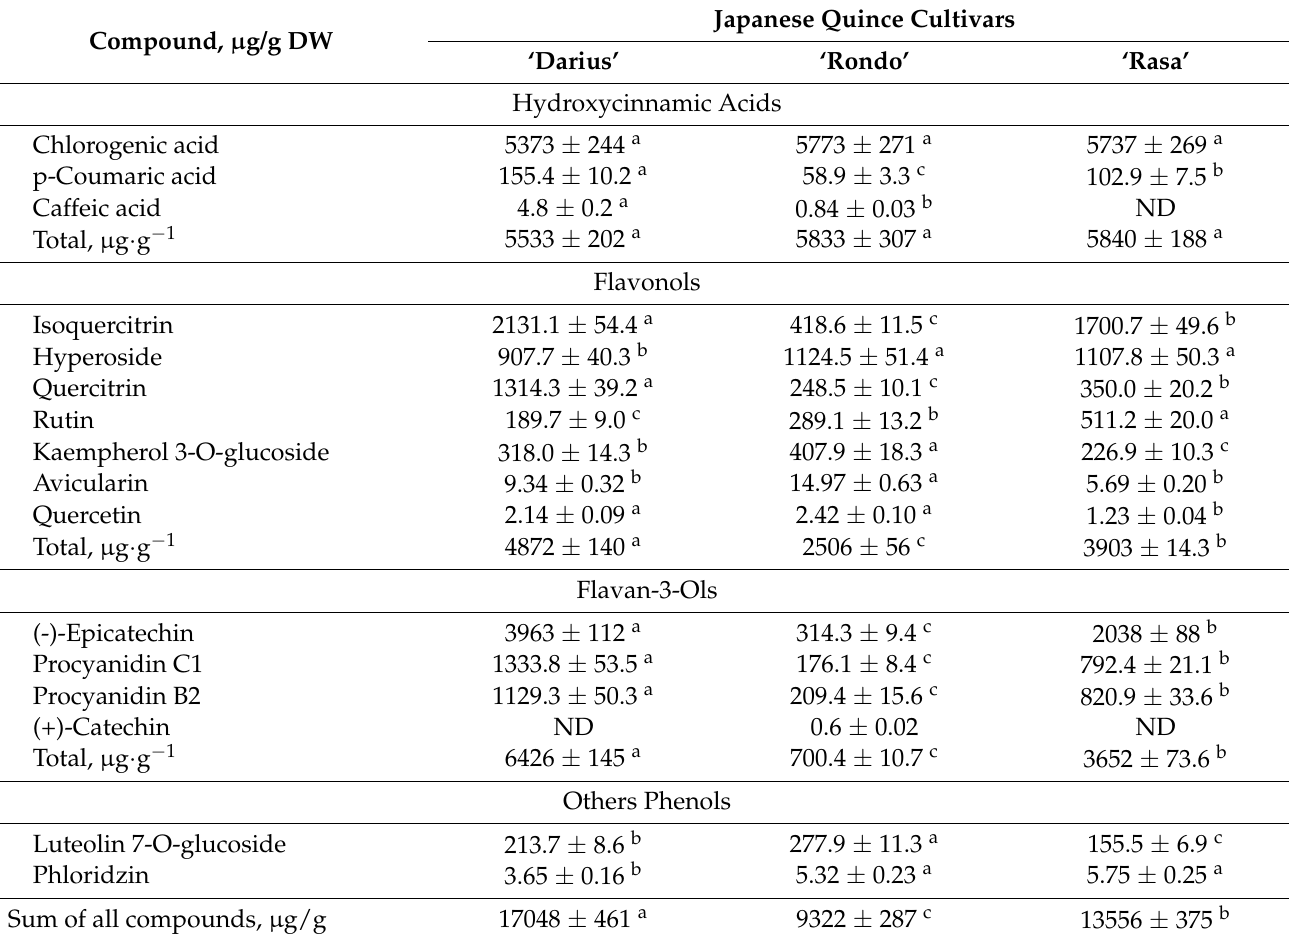
Table 2. Quantitative composition of phenols in Japanese quince leaves, µ g/g